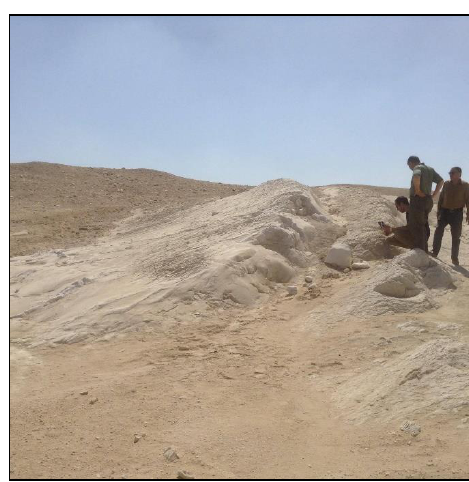
Figure 14: Inside the